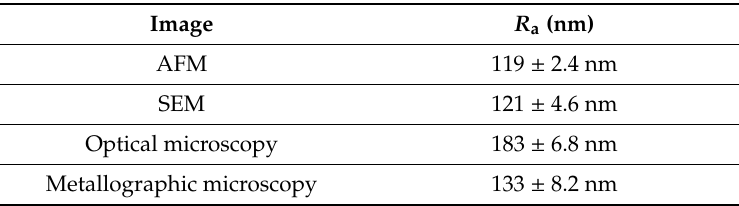
Table 1. R a roughness parameters of 25MgHAp coatings.